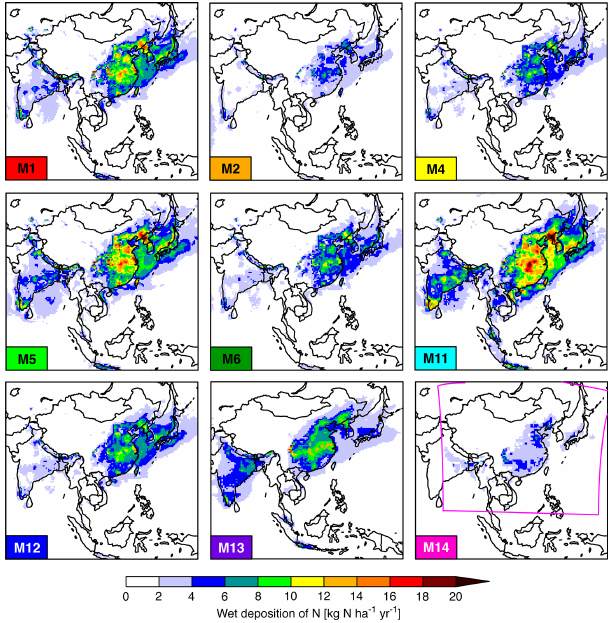
Figure 6. Spatial distributions of the annual accumulated wet depo- sition of